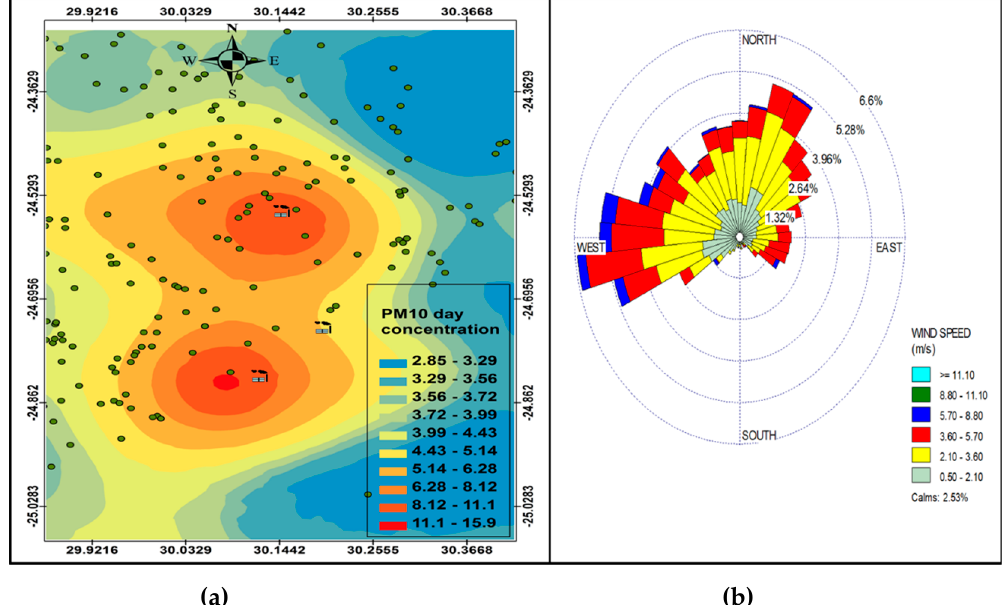
Figure 5. Annual variation in PM 10 ( µ g.cm − 3 ) concentration during day-time ( a ), wind rose during the day ( b ).